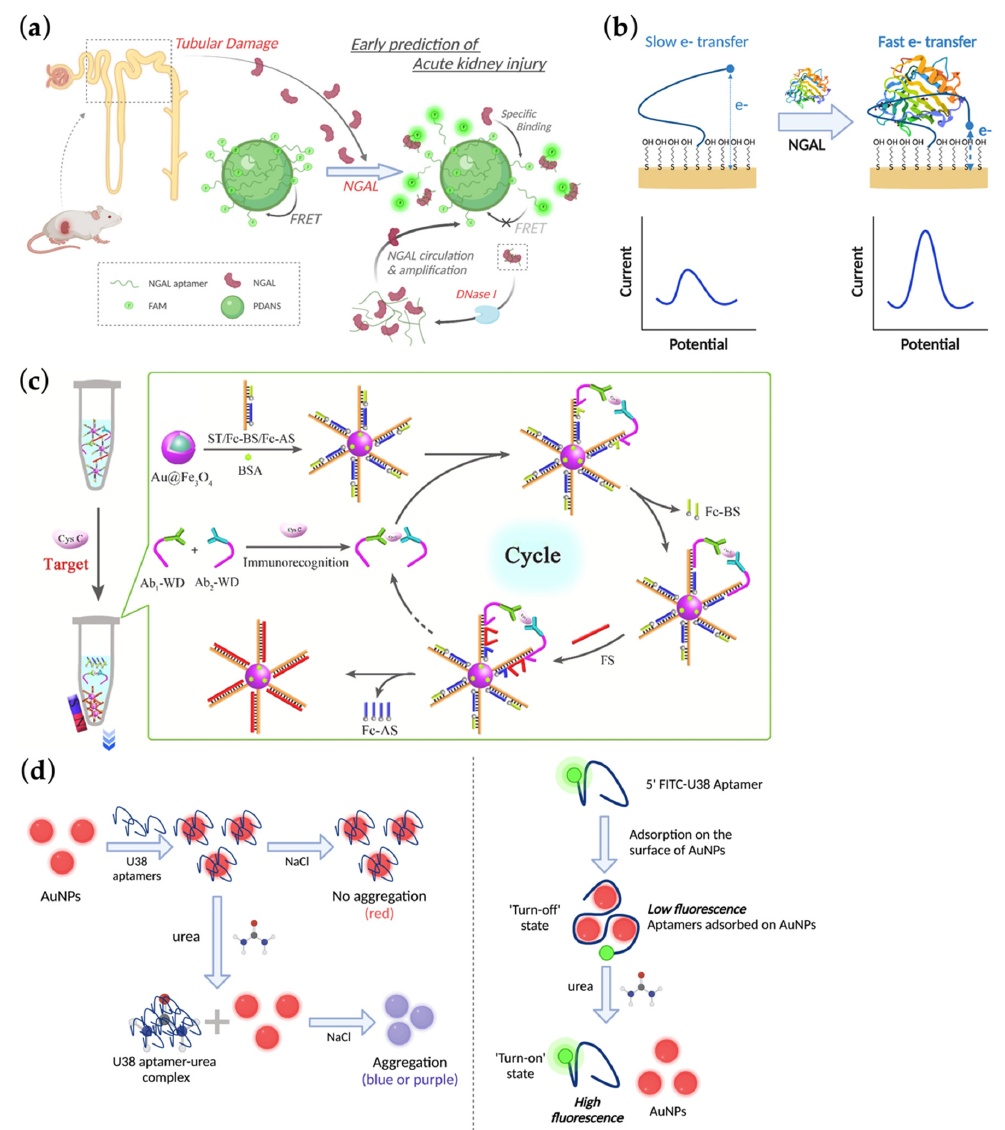
Figure 2. Mechanisms involved in aptamer-based detection of acute kidney injury (AKI)-related proteins and small molecules. ( a ) Schematic illustration of how specific binding between polydopamine nanosphere-attached aptamers and AKI biomarker neutrophil gelatinase-associated lipocalin (NGAL) turns on the fluorescence signal and amplified with the help of DNase I-mediated NGAL circulation. Adapted with permission from [20] and created with BioRender.com (27 February 2022). Copyright © 2022, Royal Society of Chemistry; ( b ) Diagrammatic plot of the relationship between the current signal within an electrochemical aptamer-based sensor and the DNA strand folding induced by specific NGAL binding. Adapted with permission from [22] and created with BioRender.com (27 February 2022). Copyright © 2022, American Chemical Society; ( c ) Detailed mechanism of how antibody-cystatin C recognition induces a repeating series of DNA strand replacement through a 3D DNA machine, as well as a magnetic separation and signal detection via designed eletrochemiluminescent nanomaterials. Adapted with permission from [25]. Copyright © 2022, Elsevier; ( d ) Diagrams of two different kinds of gold nanoparticle-functionalized aptasensors detecting urea based on colorimetric changes (left) and fluorescence quenching/restoration (right), respectively. Adapted with permission from [31] and created with BioRender.com (27 February 2022). Copyright © 2022, Elsevier.